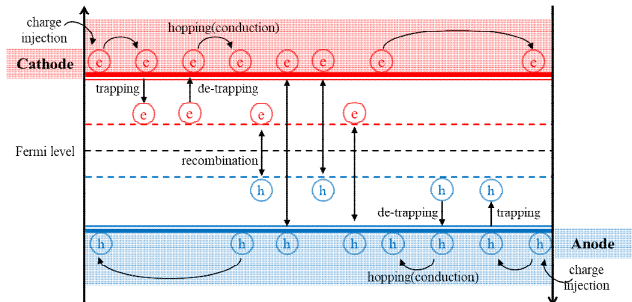
Figure 1. Overall mechanism of the Bipolar Charge Transport (BCT) model.